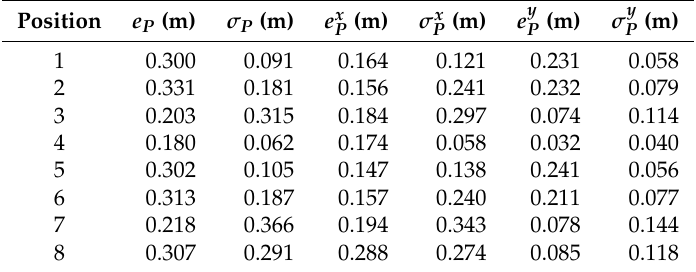
Table 7. Measured accuracy of the PSO algorithm in Scenario 3.